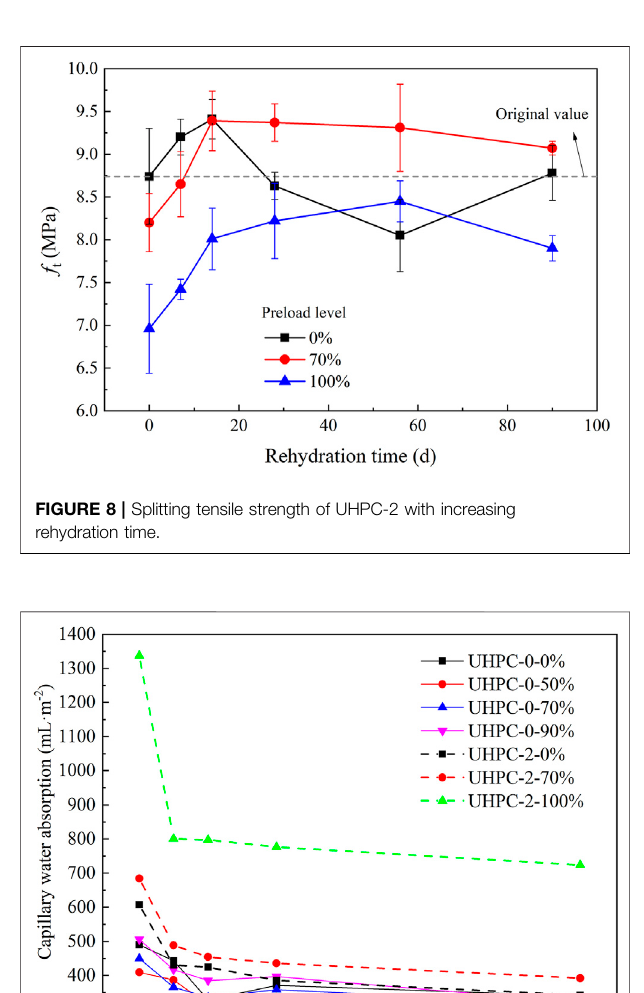
Frontiers in Materials |